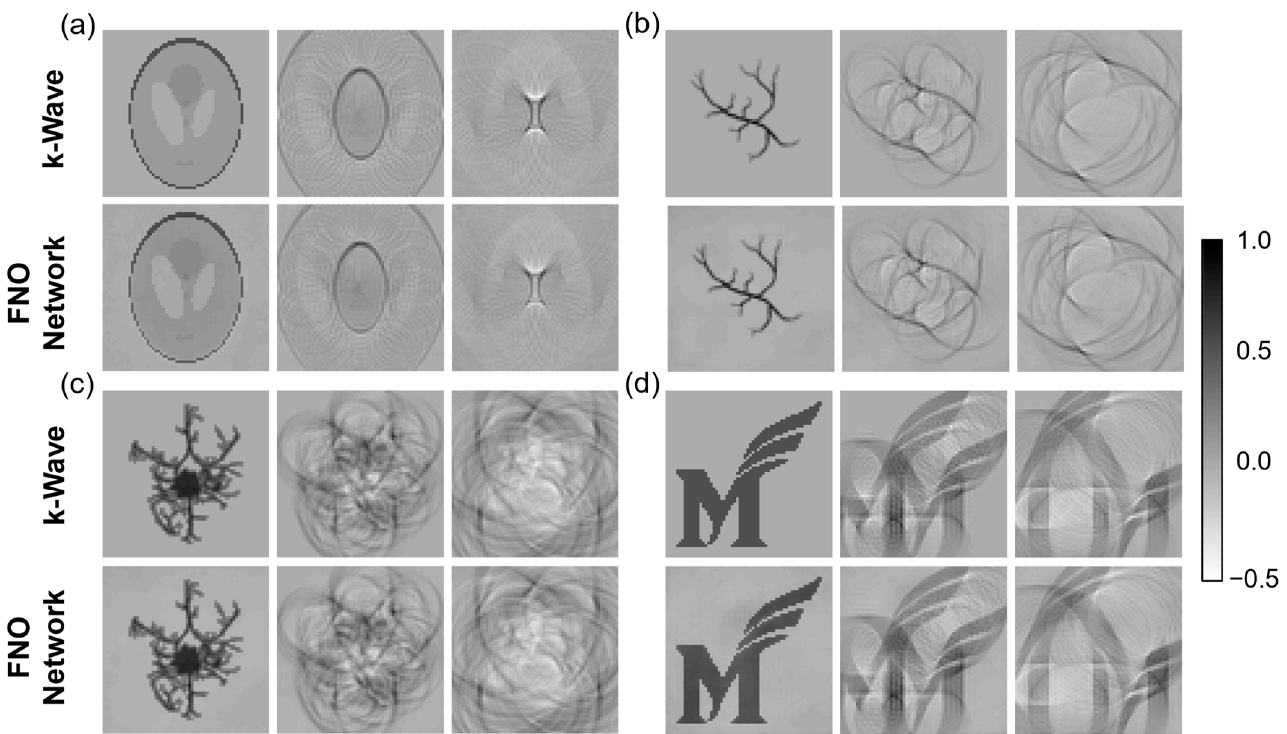
Figure 6. Comparison between FNO Network and k-Wave simulations for initial pressure sources using the ( a ) Shepp–Logan, ( b ) synthetic vasculature, ( c ) tumor and ( d ) Mason-M phantoms at t = [1, 10, 20] time steps.